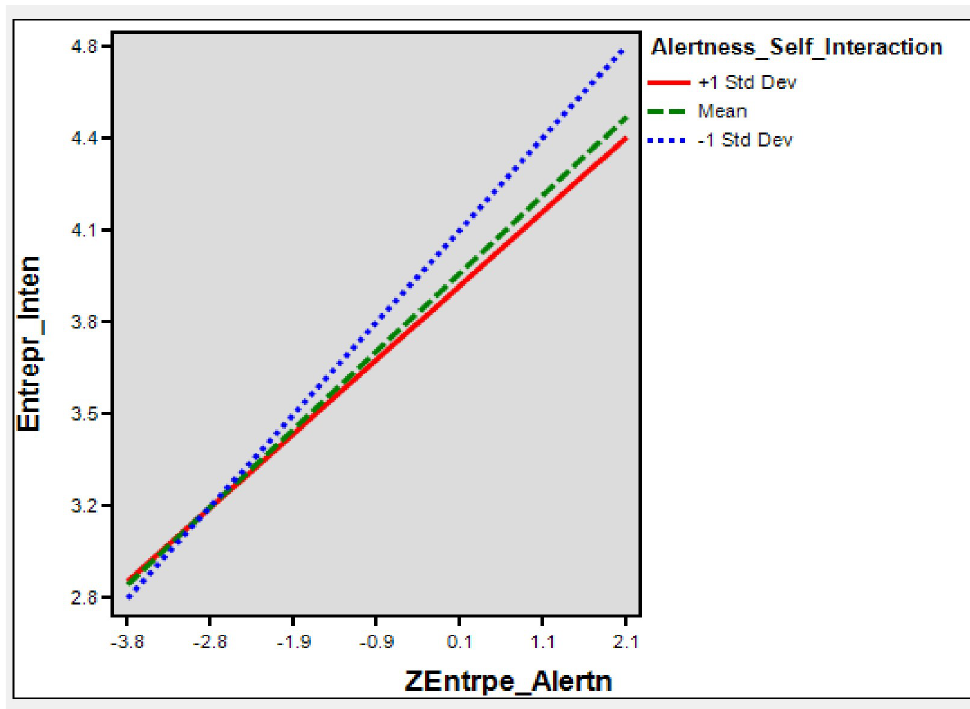
Fig 6. Interaction ESE-EA and